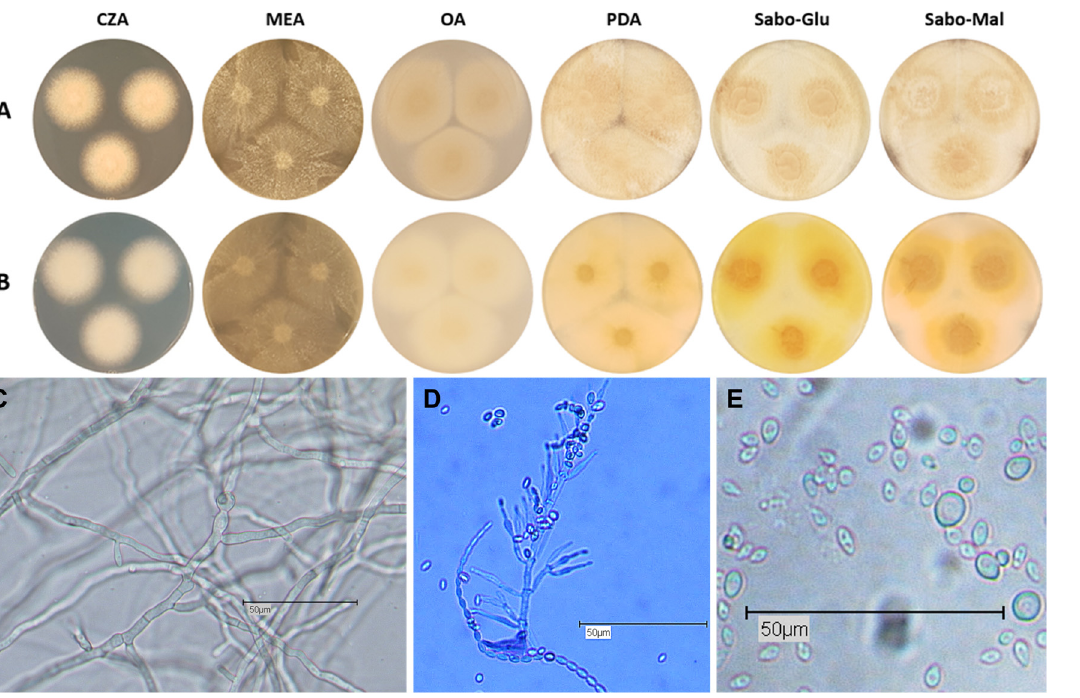
Figure A2. Macroscopic and microscopic characteristics of Paecilomyces formosus . Growth was stud- ied on different culture media (Appendix A). A 20 µL spore suspension (5 × 10 5 spores per mL) was pipetted three times onto different solid media and incubated at 37 °C for five days. ( A ) Surface growth and ( B ) colony reverse were documented photographically. Using transmitted light micros- copy (light microscope DMRBE, Leica, Wetzlar, Germany), ( C ) hyphal growth, ( D ) conidiophore structure and ( E ) spores of Paecilomyces formosus were examined.